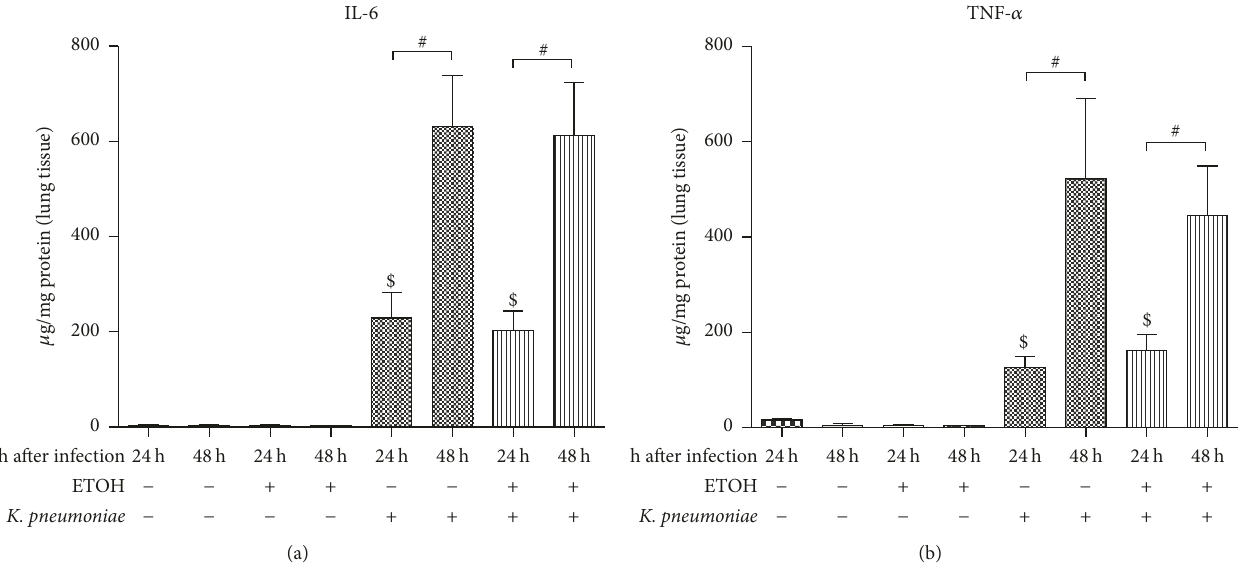
Figure 7: Protein levels of (a) IL-6 and (b) TNF- 𝛼 in lung tissue in a murine model of ethanol exposition for 2 weeks, surgery, and pulmonary infection. Protein levels of indicated cytokines were analyzed by cytometric bead array (CBA) and given as 𝜇 g/mg protein of lung tissue in the lung of ethanol-treated (ETOH) and saline-treated controls (NaCl) at 24 hours or 48 hours after pulmonary infection with Klebsiella pneumoniae . $ 𝑝 < 0.05 when compared to time- and treatment-matched control (infection-dependent effects); # 𝑝 < 0.05 when comparing 24 hours to 48 hours (time-dependent effects); data are presented as mean ± SEM, Mann–Whitney U test ( 𝑛 = 8 each group). IL: interleukin; TNF- 𝛼 : tumor necrosis factor; ETOH: ethanol treatment; K . pneumoniae : pulmonary infection with Klebsiella pneumoniae